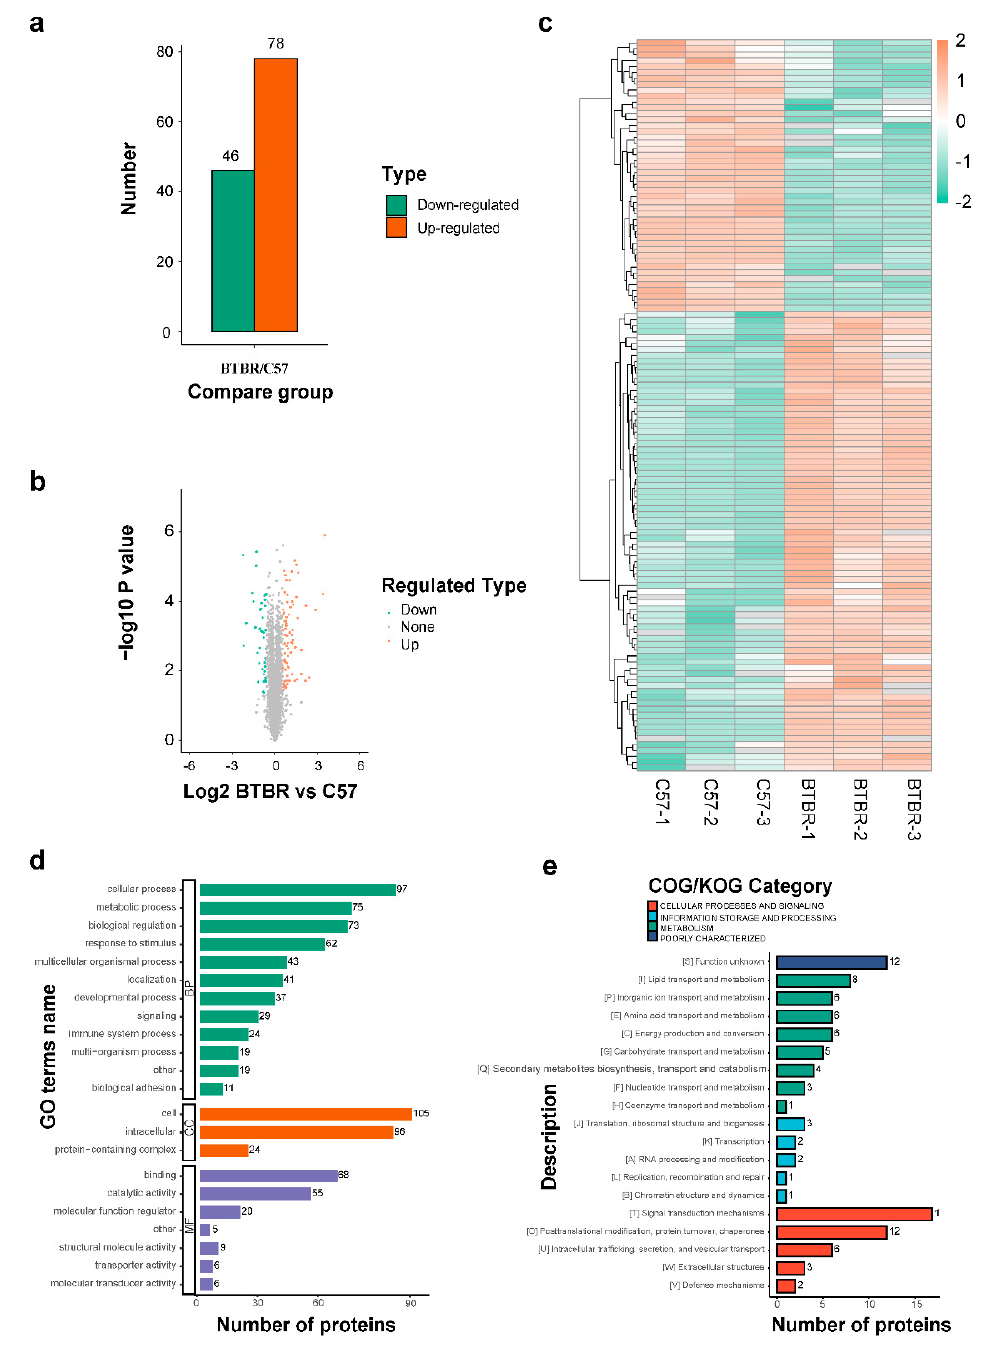
Figure 2. Identification of differential proteins ( a – c ) and GO/KOG functional classification ( d , e ). ( a ) The number of differentially expressed proteins was identified. Among them, 78 proteins were up-regulated and 46 proteins were down-regulated. ( b ) Volcanic map of differentially expressed proteins. Red represents upregulated proteins and green represents downregulated proteins. ( c ) Heatmap of differentially expressed proteins. Each small square represents a protein and the color indicates the level of expression. Red represents up-regulation and green represents down-regulation. The darker the color, the greater the expression. ( d ) GO functional classification of differentially expressed proteins. The abscissa represents the number of proteins and the ordinate represents the GO term name. ( e ) KOG functional classification of differentially expressed proteins. The abscissa indicates the number of proteins and the ordinate indicates the functional names in the different COG/KOG categories.